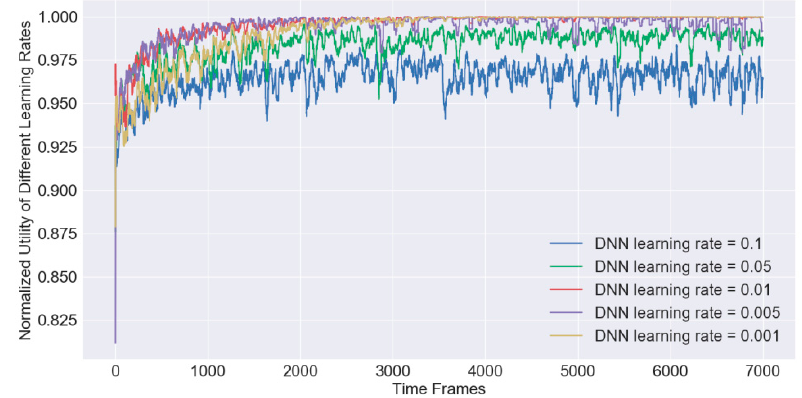
Figure 6. The IRAO training processes of different learning rates.